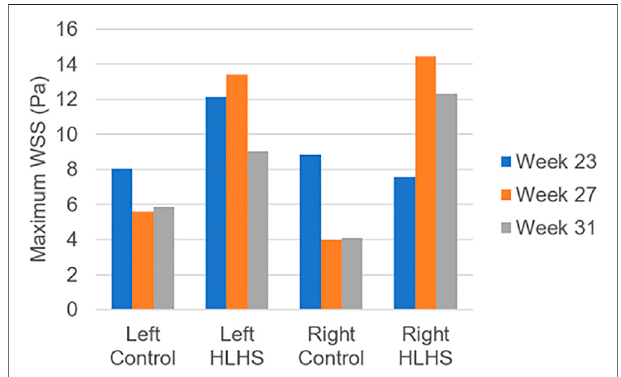
FIGURE 11 | Temporal averages of maximum WSS levels during one cardiac cycle for the control and HLHS hearts at weeks 23, 27, and 31.